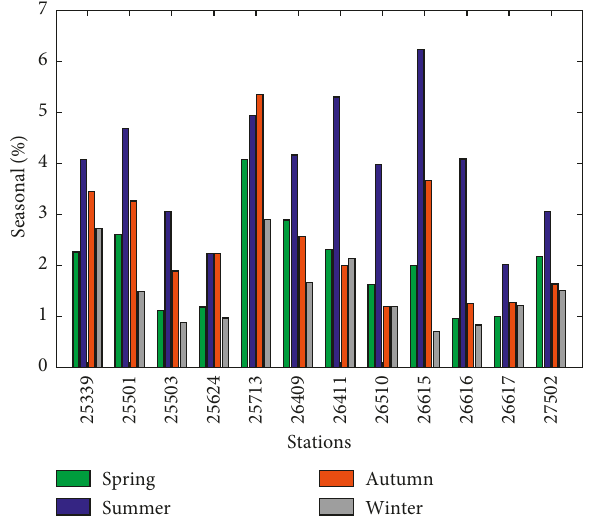
Figure 6: Seasonal (spring, summer, autumn, and winter) average probability (%) distributions of surface ducts at 12 stations in Alaska.